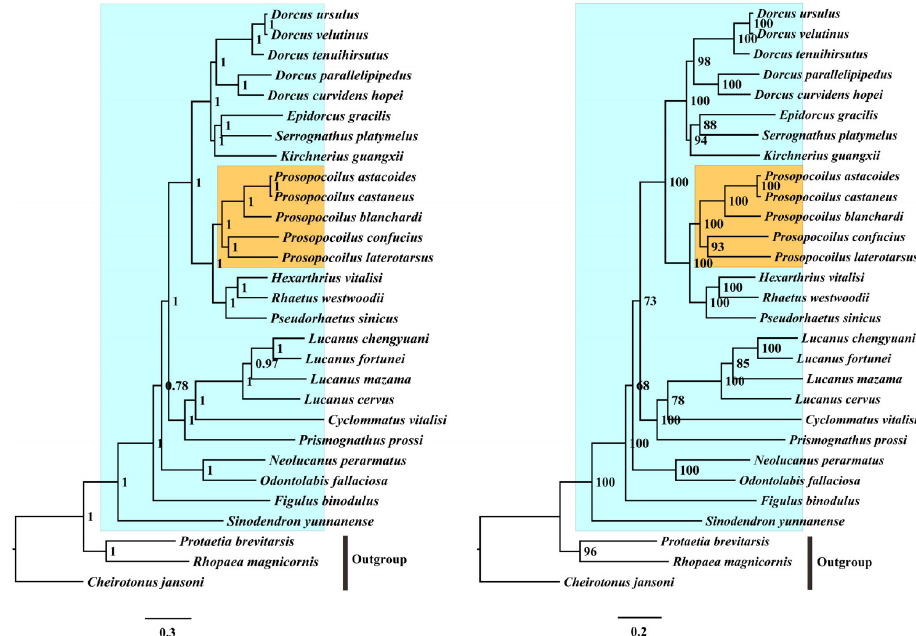
Figure 5. Phylogenomic relationships of Lucanidae inferred from mitogenomes. Three other scarab species ( Cheirotonus jansoni , Rhopaea magnicornis, and Protaetia brevitarsis ) were used as the outgroup. The phylogenetic topology was obtained based on the data set PCGs. Blue shading shows Lucanidae and yellow shading shows Prosopocoilus . The numbers at the nodes are BI posterior probabilities ( left ) and ML bootstrap values ( right ).